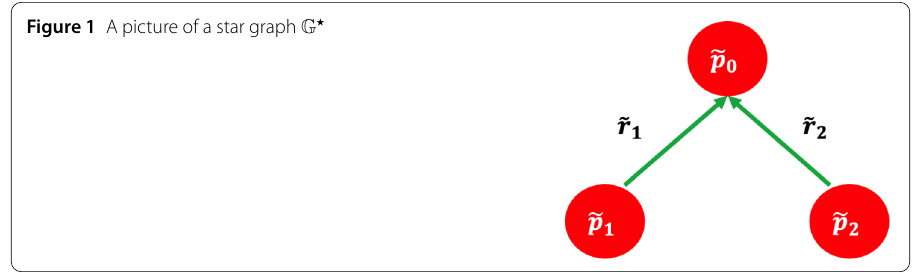
Figure 1 A picture of a star graph G